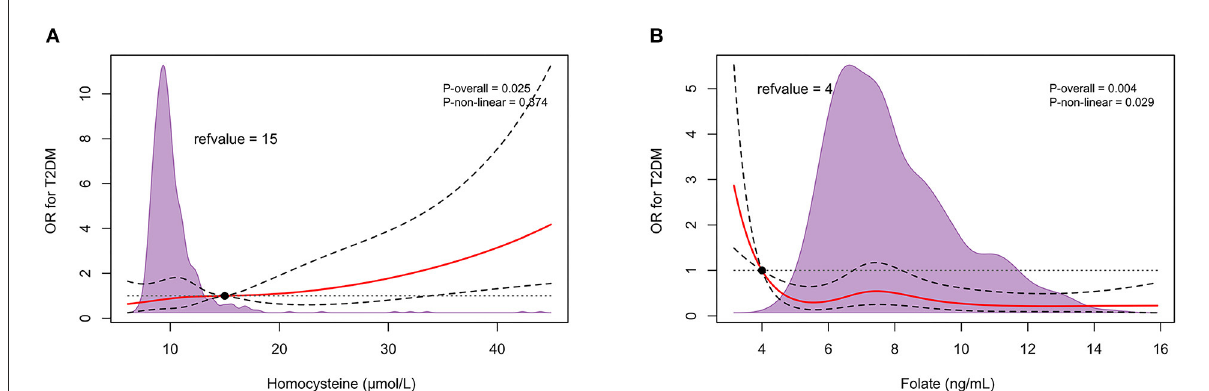
FIGURE2 In retrospective observational study, restricted cubic spline relationship between circulating homocysteine (A) , folate (B) and T2DM onset. Red solid and black dashed lines depict ORs and 95% CIs for log-transformation of hcy, folate concentrations in conditional regression models based on restricted cubic splines. Reference values were set at 15 µ mol/L and 4ng/mL, respectively, depending on the clinical normal reference range. The purple shaded area represents the distribution density of hcy and folate in the total population ( n = 772). The result has been adjusted for age; sex; body mass index; smoking history; drinking history; hypertension history; fasting total cholesterol, triglycerides, HDL cholesterol, LDL cholesterol, and glucose levels. T2DM, type 2